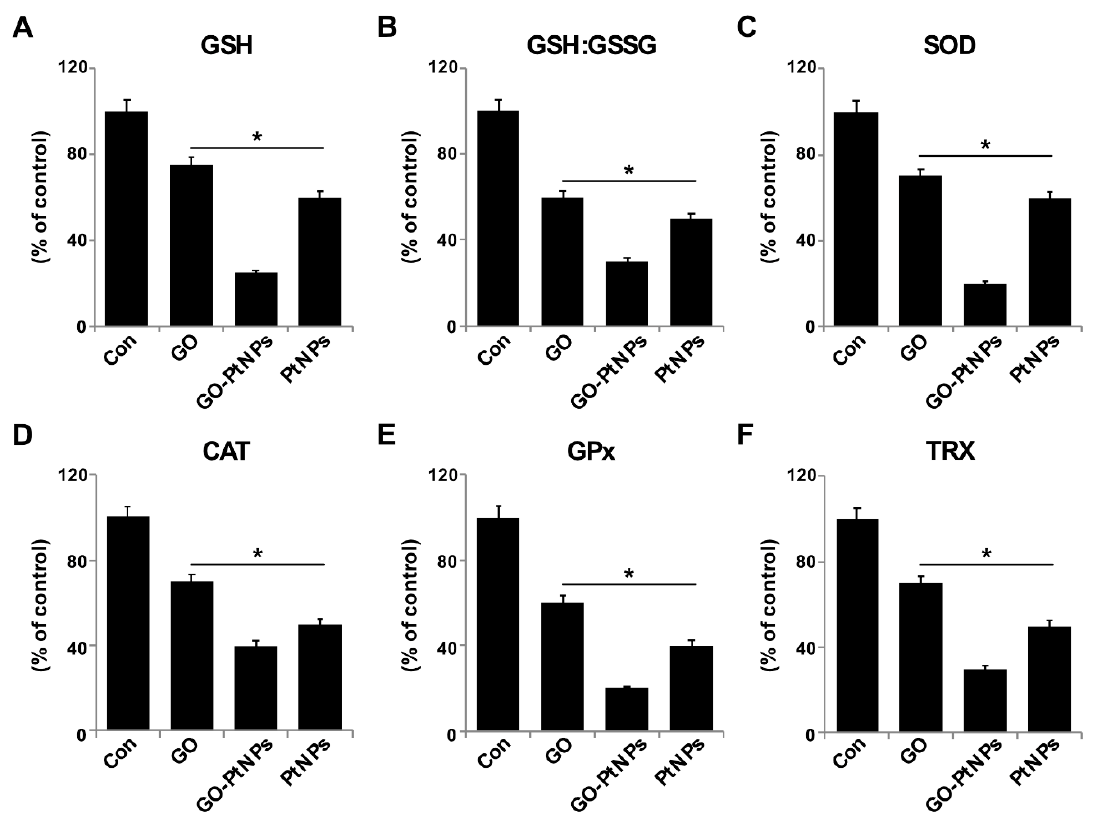
Figure 11. Effect of GO, GO-PtNPs, and PtNPs on antioxidant markers. LNCaP cells were treated with respective IC50 concentration of GO, GO-PtNPs, and PtNPs for 24 h. After incubation, cells were harvested and washed twice with an ice-cold phosphate-buffered saline solution. The cells were collected and disrupted by ultrasonication for 5 min on ice. GSH concentration is expressed as percentage of control ( A ). GSH:GSSG ratio is expressed as percentage of control ( B ). SOD concentration is expressed as percentage of control ( C ). CAT is expressed as percentage of control ( D ). GPx concentration is expressed as percentage of control ( E ). TRX is expressed as percentage of control ( F ). There was a significant difference in treated cells compared to untreated cells with Student’s t - test (* p < 0.05).